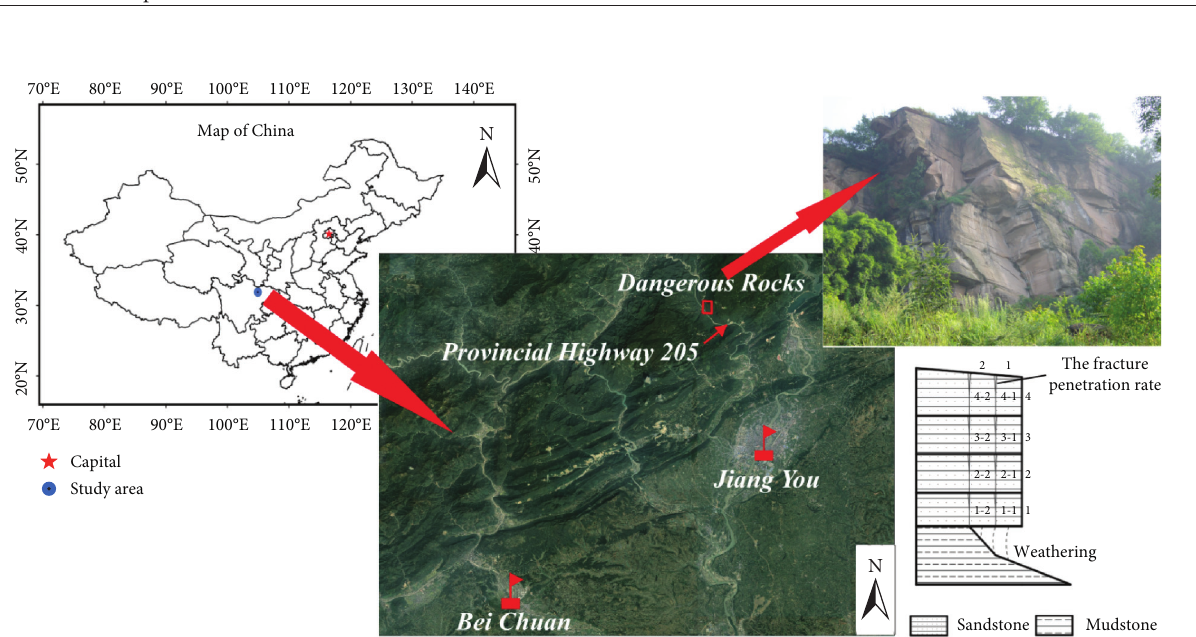
Figure 14: Damaged rock on Provincial Highway 205, Beichuan Qiang Autonomous County, Sichuan Province, China.